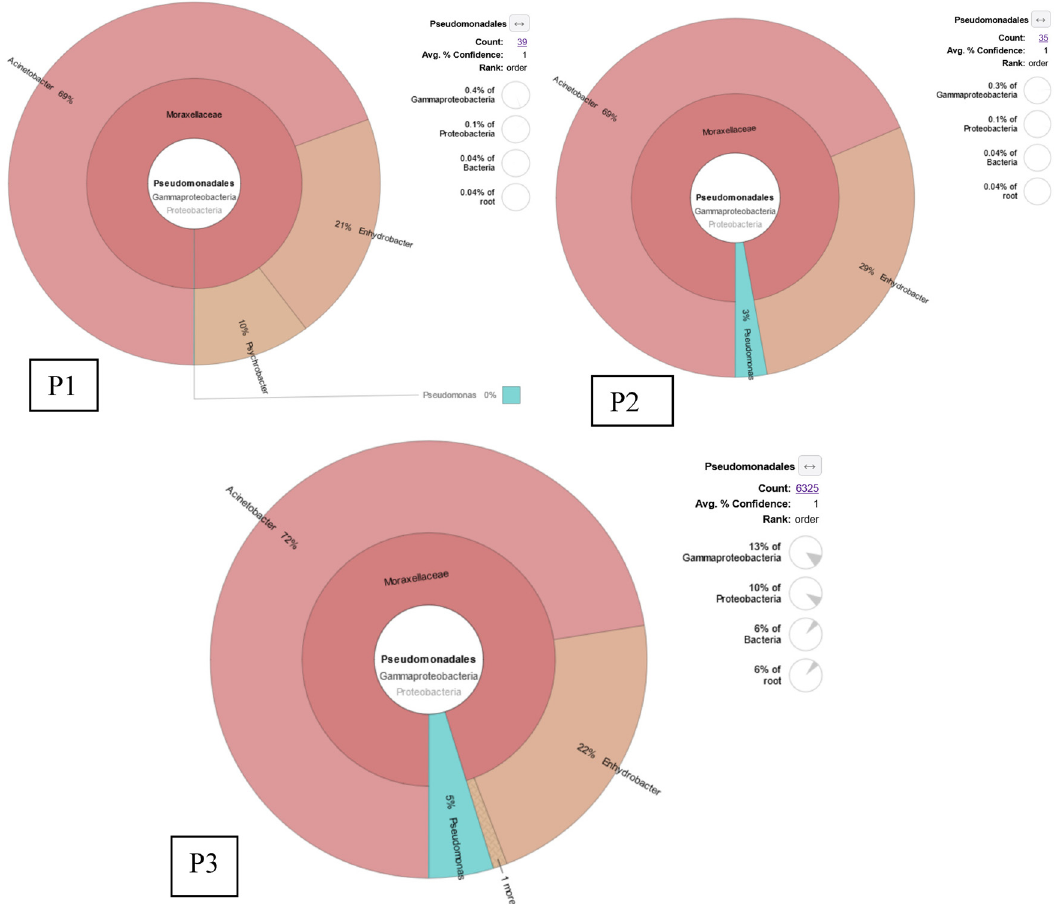
Figure 3: KRONA visually displays the analysis result of taxonomic annotation. Circles from inside to outside stand for di ff erent taxonomic ranks, and the area of the sector means a respective proportion of di ff erent OTU annotation results. The abundance of Pseudomonas spp. was detected from the rearing water of commercial shrimp ponds. P1 is pond 1, P2 is pond 2, and P3 is pond 3.